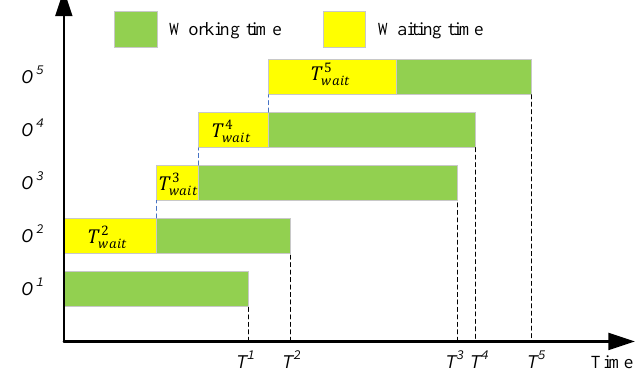
Figure 5. Waiting time and working time of each operation.